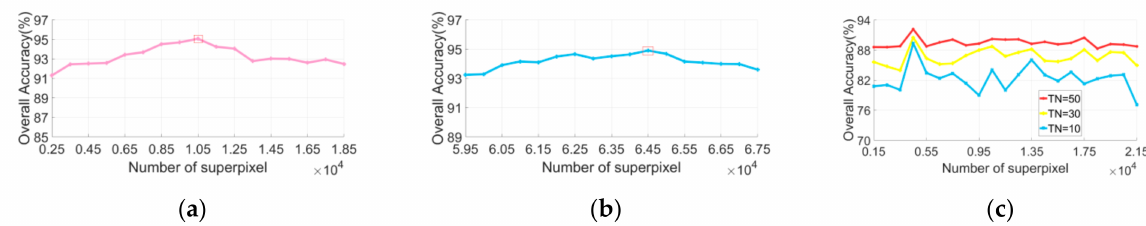
Figure 10. Effects of the number of original superpixels on ( a ) SAR1 image (TN = 50), ( b ) SAR2 image (TN = 50), and ( c ) SAR3 image (TN = 10, TN = 30, and TN = 50). TN = n means the number of training samples is equal to